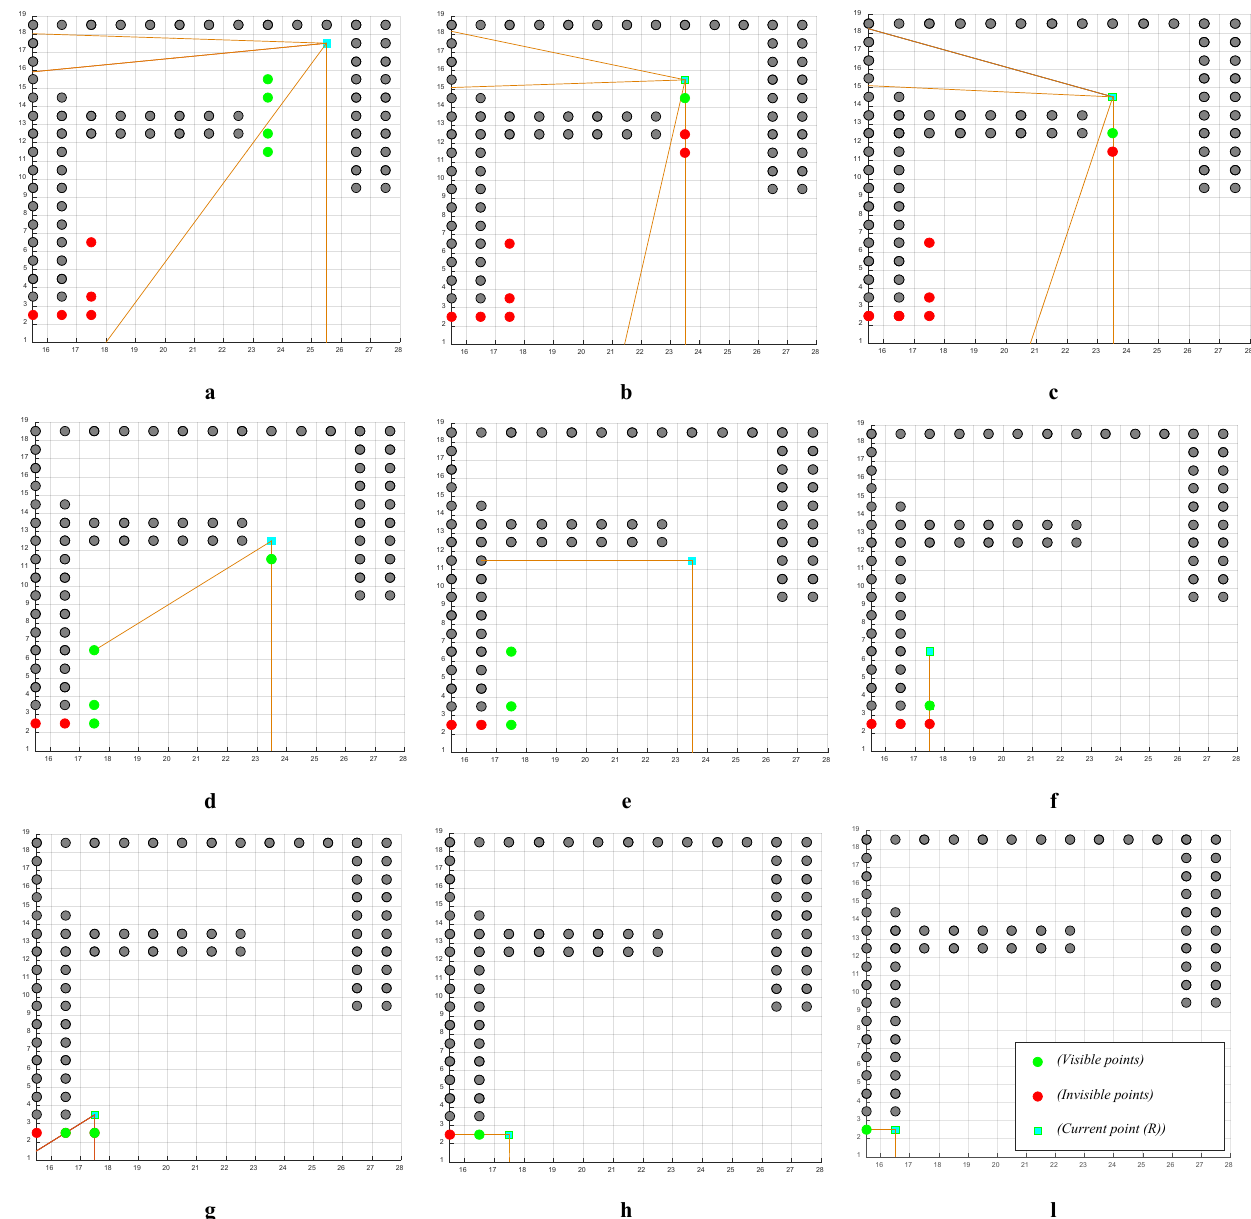
Fig. 3. Step-by-step operation of LOS procedure in the first region of the Map_1 for the first